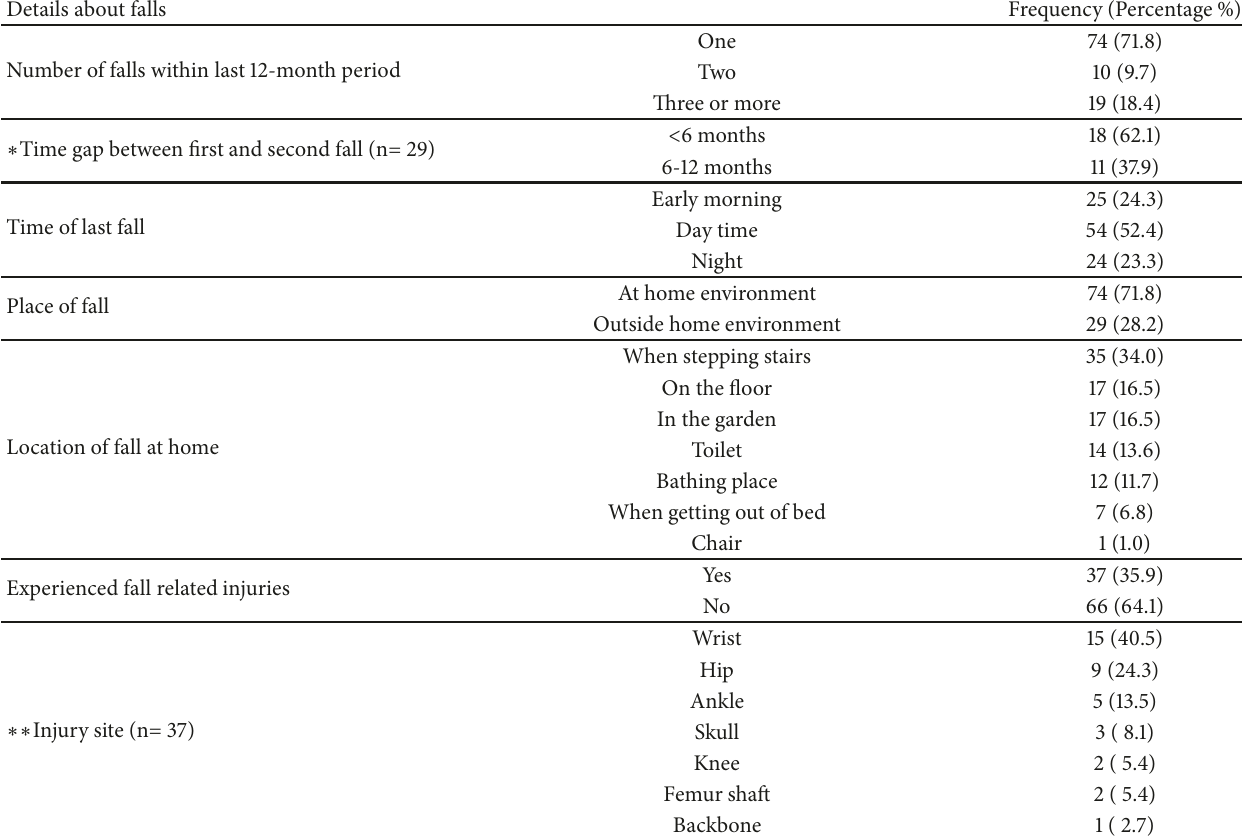
Table 2: Falls related information